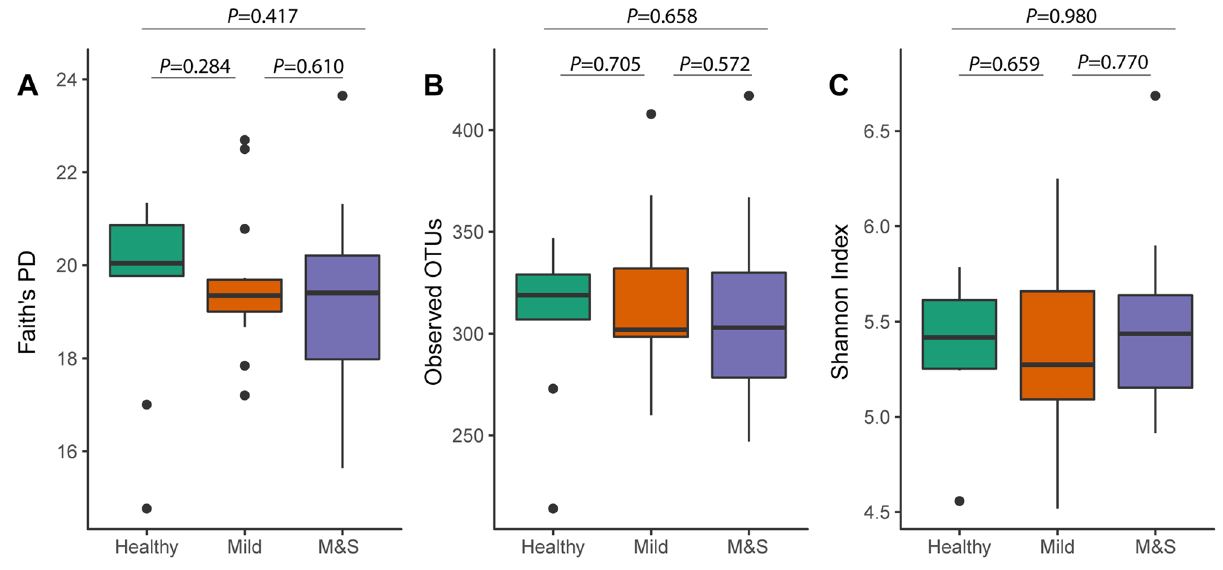
Figure 1. Salivary microbial community alpha diversity box plots showing ( A ) Faith’s PD, ( B ) Observed OTUs, and ( C ) Shannon richness by different degrees of dental